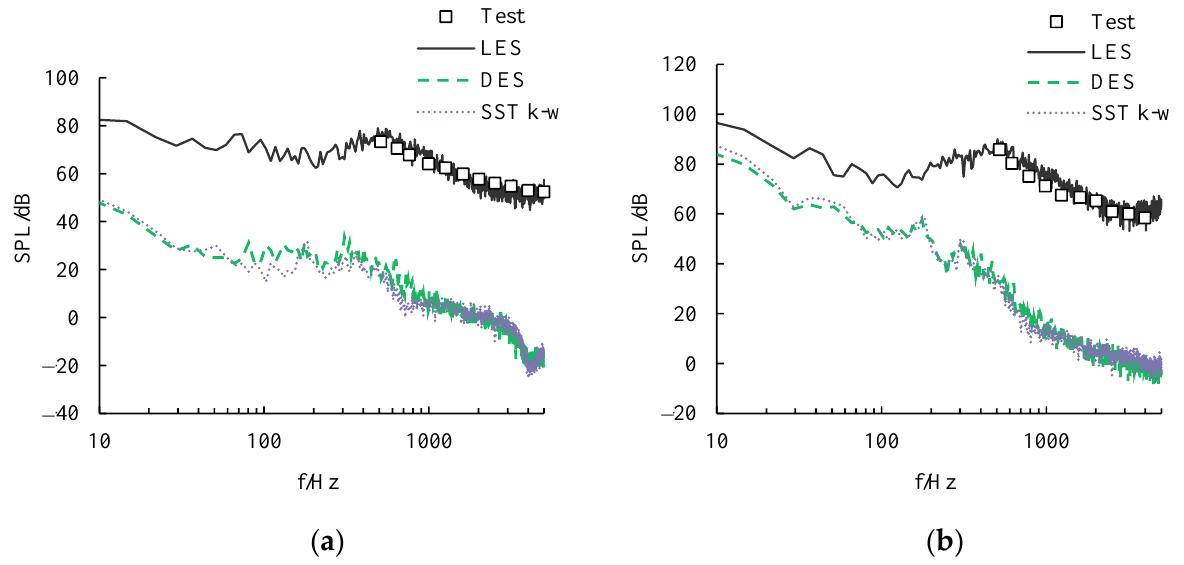
Figure 6. Comparison of calculated and experimental values of hydrophone in fluid domain: ( a ) comparison at A monitoring point; ( b ) comparison at B monitoring point.